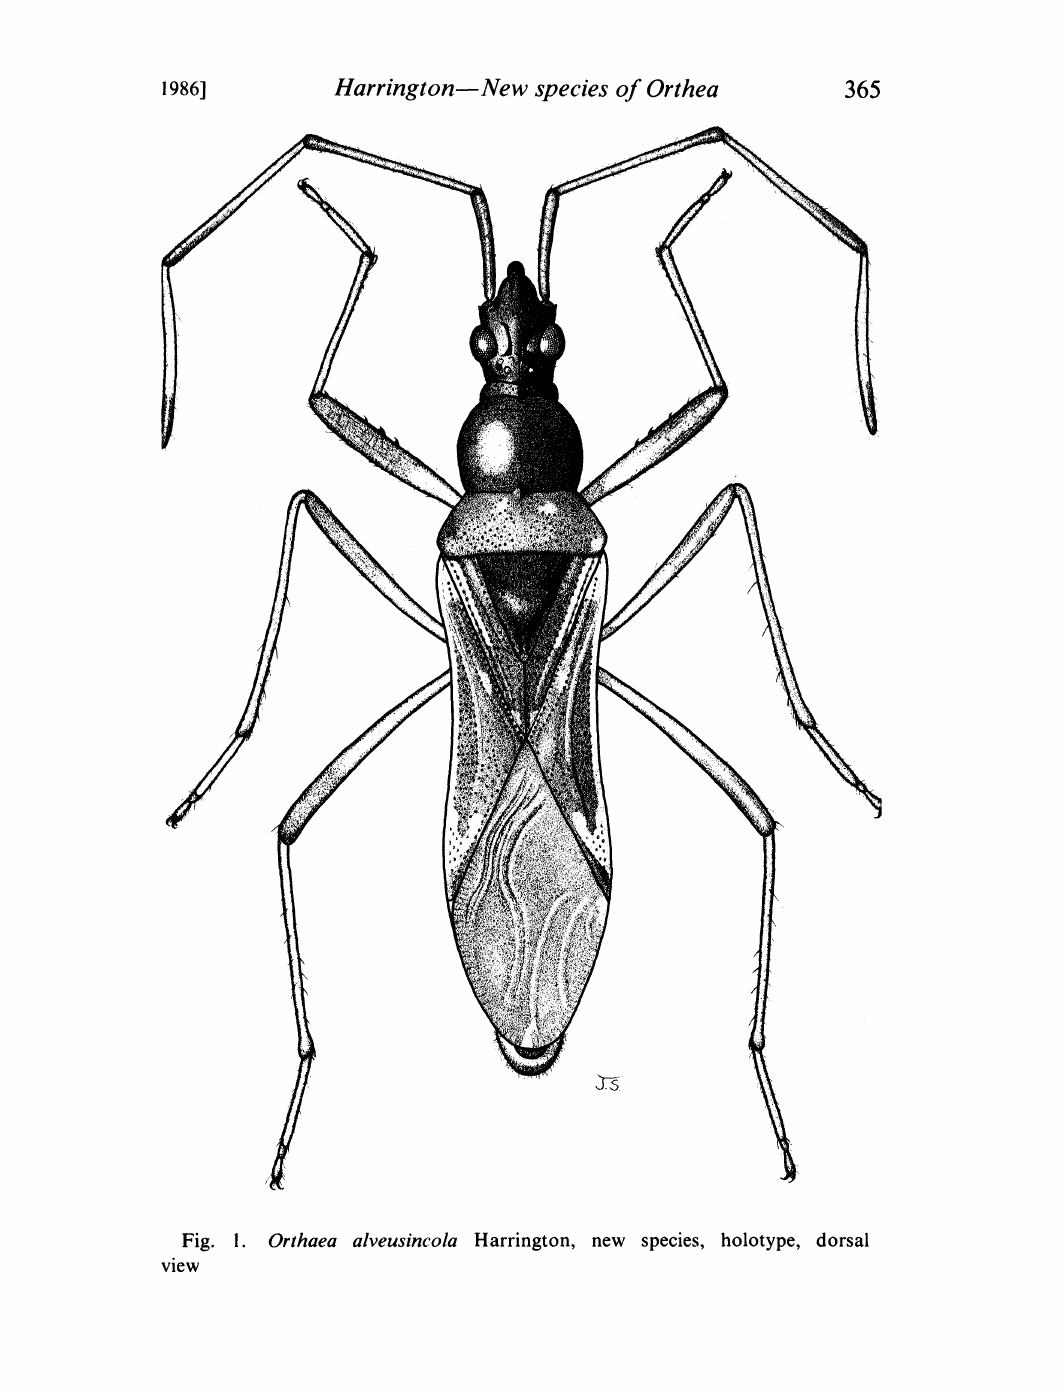
Fig. 1. Orthaea alveusincola Harrington, new species, holotype, dorsal